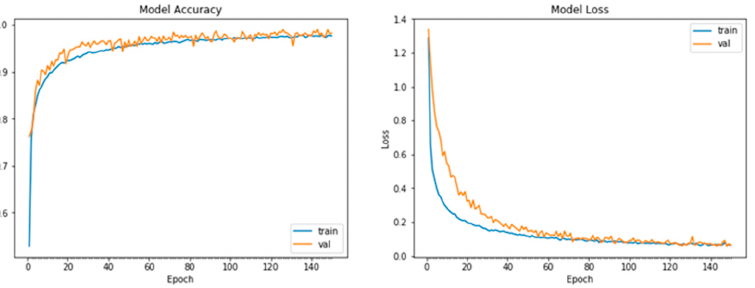
Figure 3. Plot of best-performing NADAM with increasing CNN depth + width on Fashion MNIST.